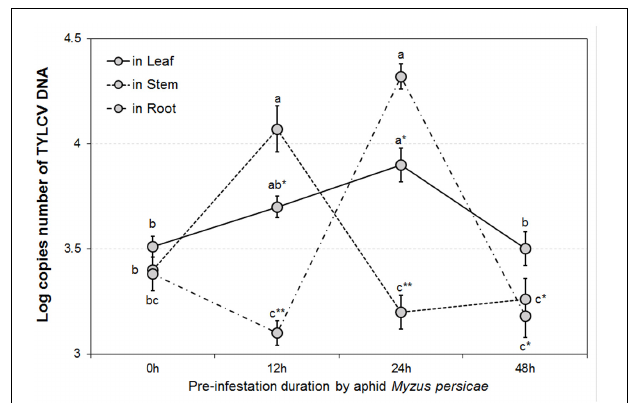
FIGURE 2 | TYLCV DNA concentrations in different tomato plant parts after feeding by TYLCV-infested Bemisia tabaci according to various Myzus persicae pre-infestation duration treatments. The error bars are standard errors of the mean. Colored letters indicate significant differences of DNA concentration among different aphid pre-infestation durations in each tomato plant part, and ‘ ∗ ’ indicates significant differences among three plant parts in the same pre-infestation duration according to Duncan’s test at P =